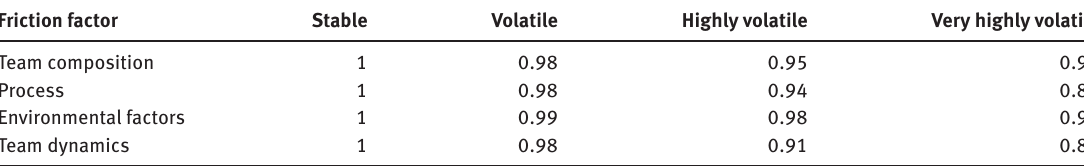
Table 2: Friction Factors.